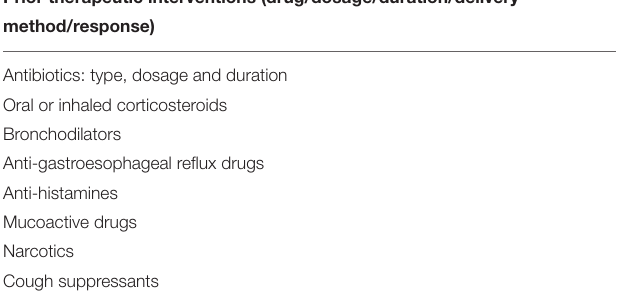
TABLE 10 | Prior therapeutic